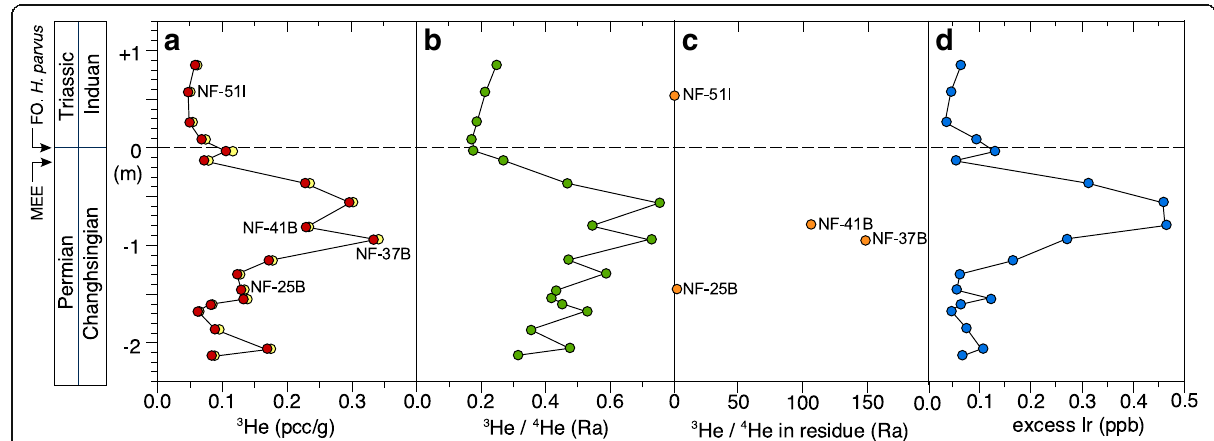
Fig. 2 Stratigraphic He and Ir profiles. Stratigraphic profiles of a 3 He concentrations, b 3 He/ 4 He ratios, c 3 He/ 4 He ratios of acid-insoluble residues produced during stepwise heating at temperatures of 750 – 950 °C, and d excess Ir in bedded cherts of the Waidani section. Red and yellow symbols in the 3 He profile represent the extraterrestrial fraction and measured 3 He concentrations, respectively. The base of the Triassic and MEE horizons in this section are defined by the occurrence of the conodont Hindeodus parvus and disappearance of Permian radiolarian fossils, respectively